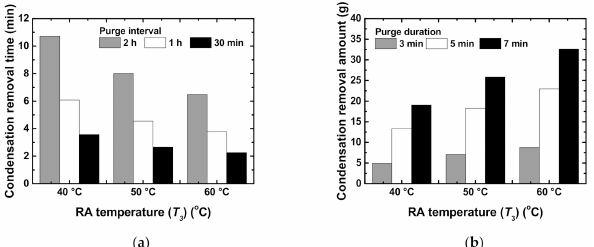
Figure 10. Result of Case 3 according to the RA temperature ( T 3 ): ( a ) time taken to remove condensation at various purge intervals; ( b ) condensation removal quantity at various purge